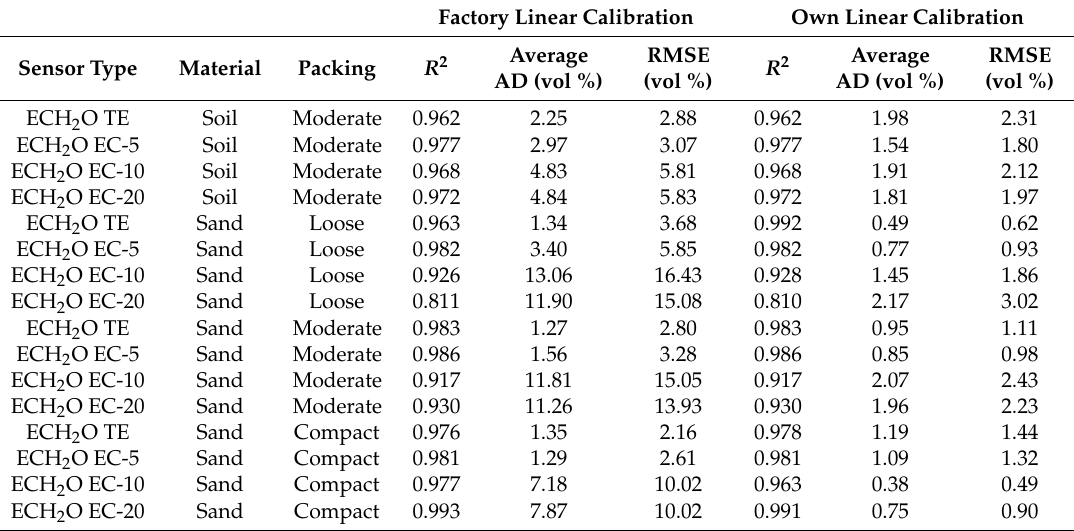
Table 7. Performance comparison of factory and own calibrations for direct regression approach